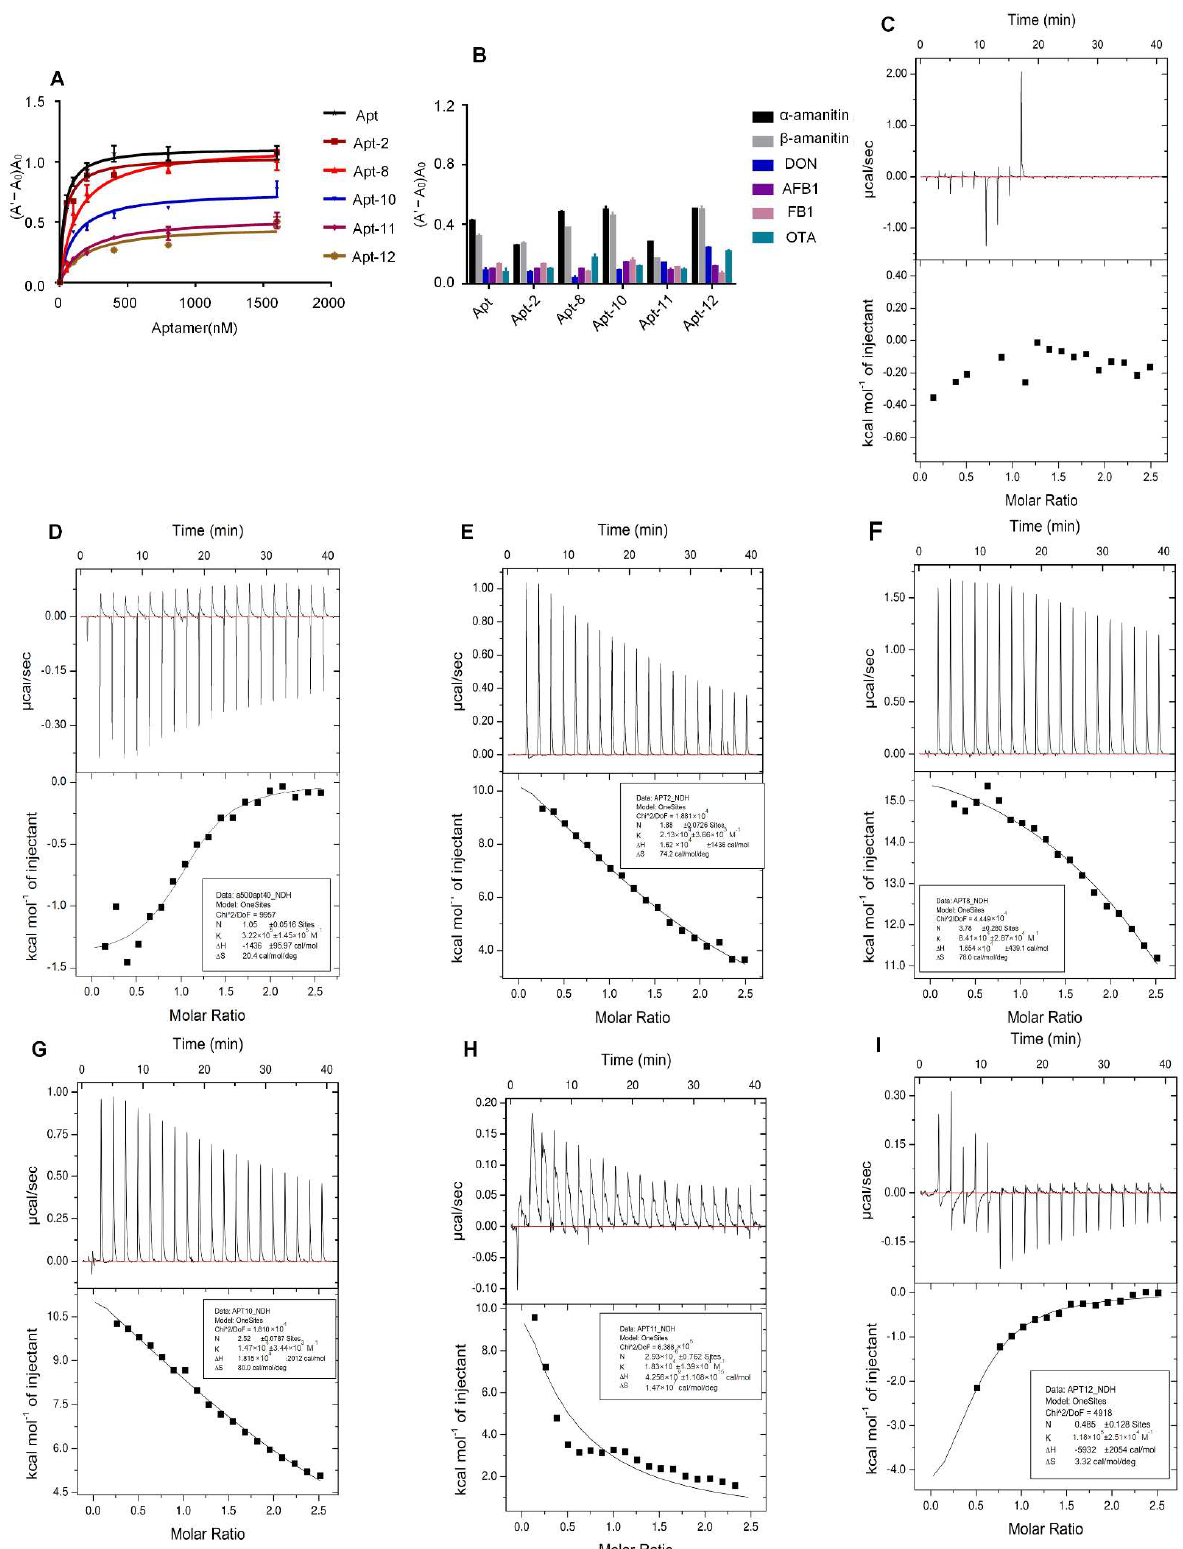
Figure 3. Haracterization of the α -amanitin aptamer and truncated aptamer. ( A ) Determining α - amanitin aptamer and truncated aptamer affinity. The aptamer concentrations (0, 50, 100, 200, 400, 800, and 1600 nM) were combined with equal amounts of α -amanitin (1 µ g/mL), and the Kd